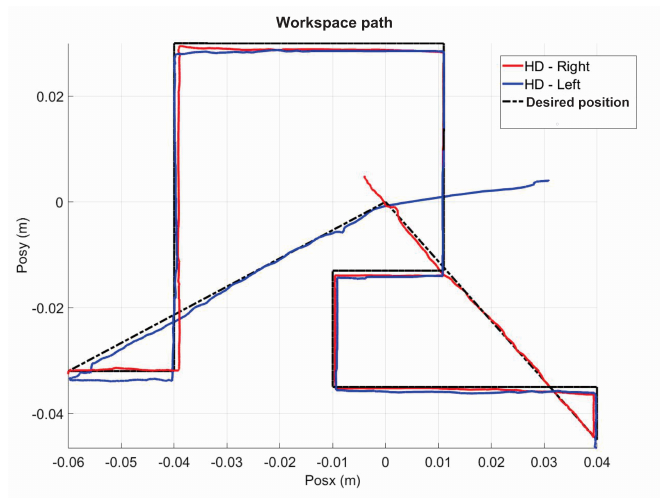
Figure 17. Workspace trajectory of two haptic devices in passive haptic guidance task: exercise